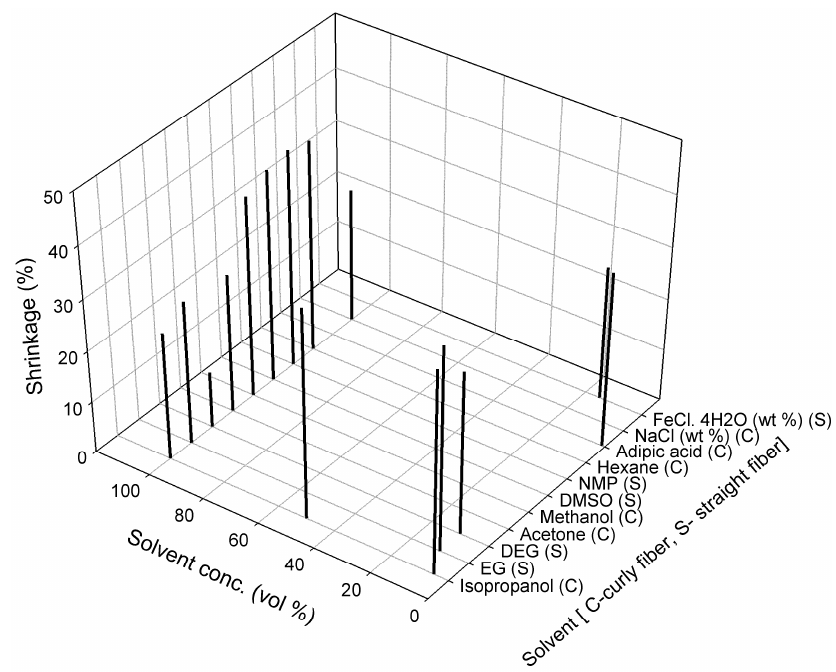
Figure A3. Effect of different solvent treatment (aqueous solutions) (after deacetylation) on shrinkage of dried cellulose fibers.